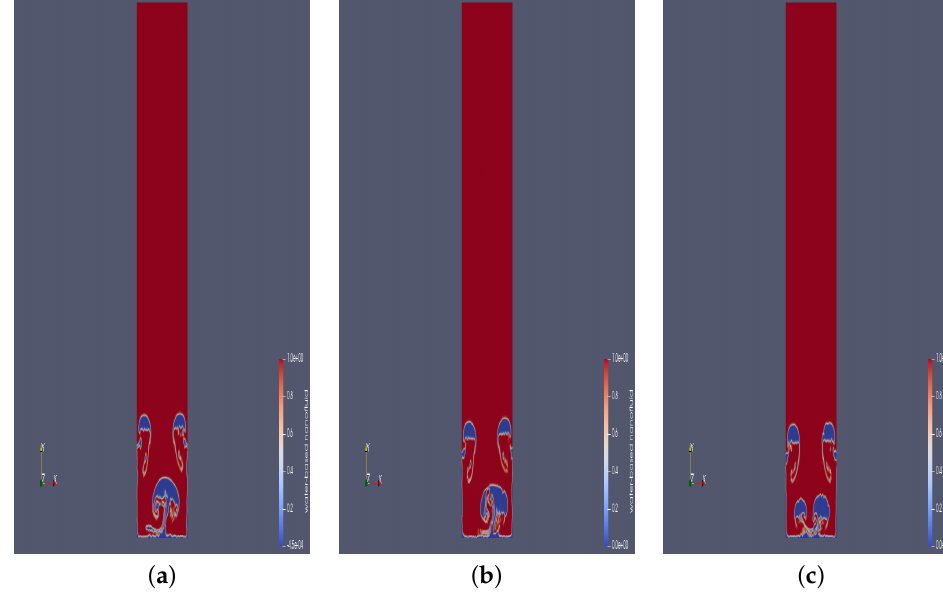
Figure 3. Mesh dependence of solutions for a water-Al 2 O 3 nanofluid. ( a ) M 1 = 100,000 cells. ( b ) M 2 = 114,400 cells. ( c ) M 3 = 121,900